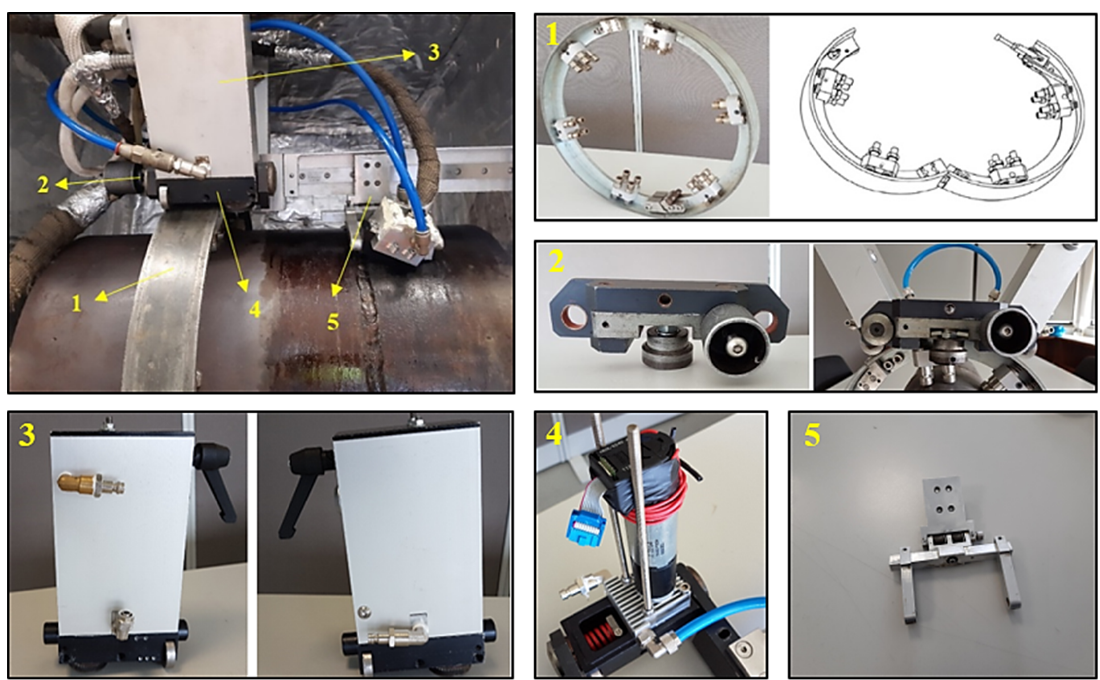
Figure 1. Automated inspection system elements.